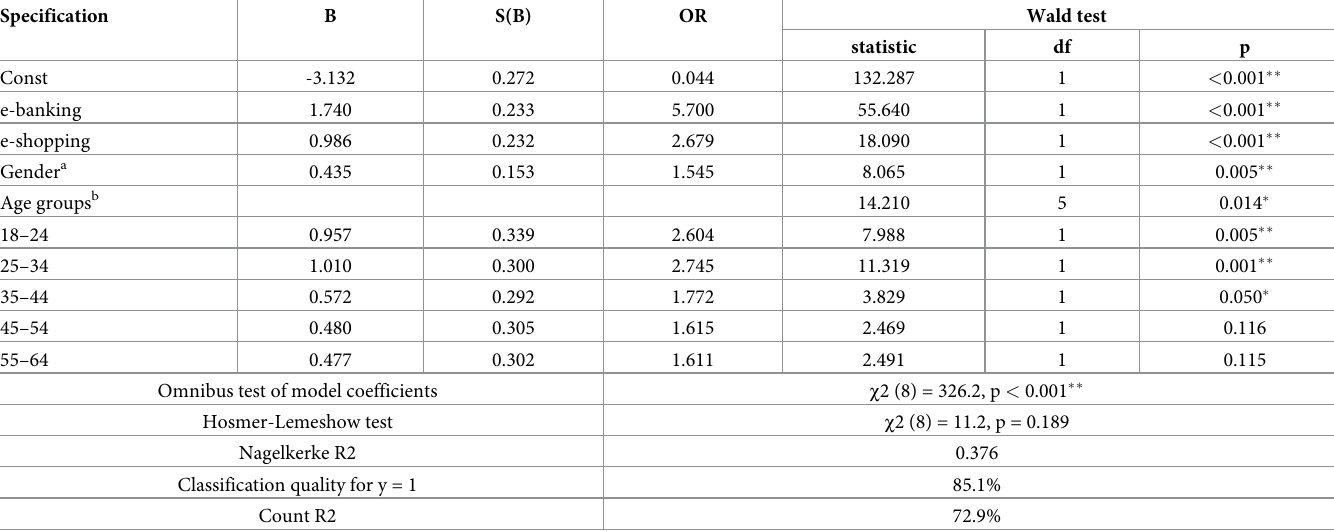
Table 7. Probability of the SE openness (SEOD) in the context of the age groups–logistic regression results (model 1).